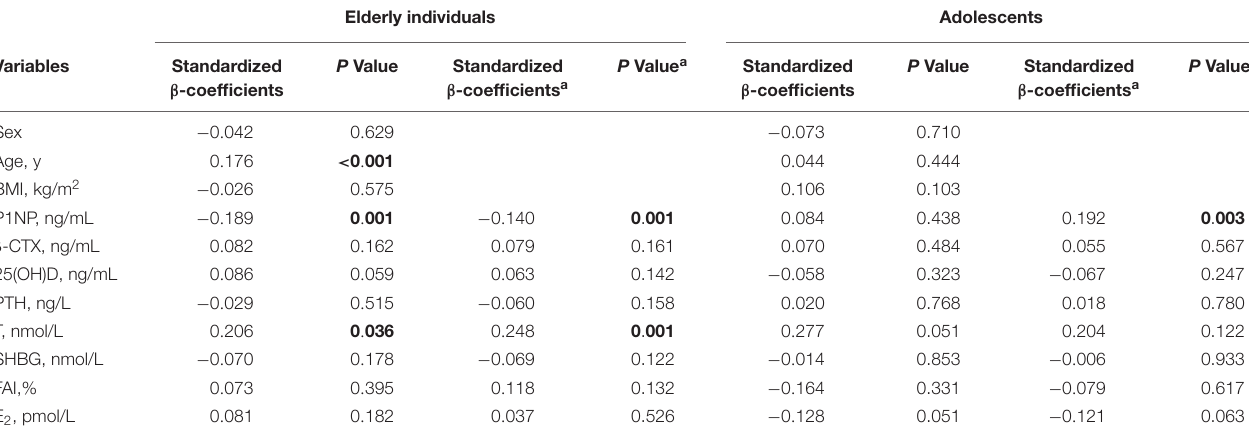
TABLE 3 | Multiple linear regression analyses between sclerostin and the correlated factors. Elderly